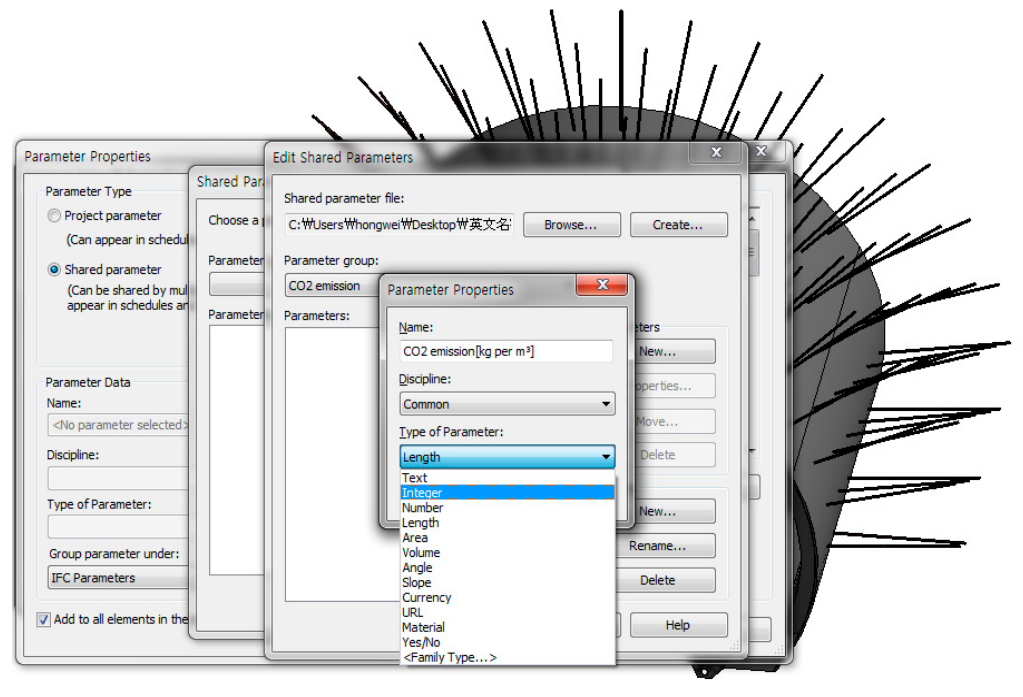
Figure 5. Editing parameter of CO 2 emission factor.